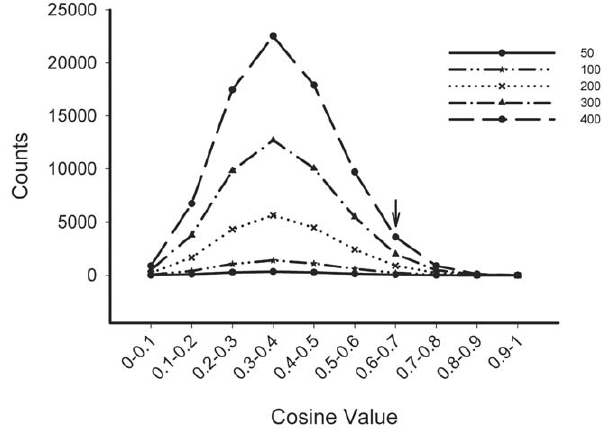
Figure 2. Distribution of cosine similarity scores for randomly selected gene sets ranging from 50 to 400 genes. The cosine value 0.6 (arrow) represents approximately 5% of the total number of cosine scores in the collection.